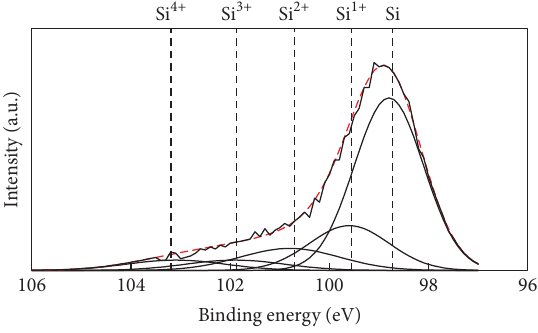
Figure 8: Si2 p XPS spectrum of the composite.